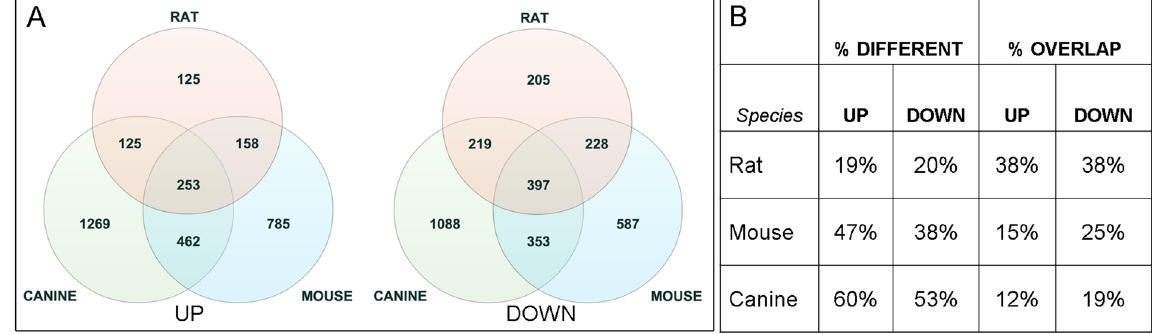
Figure 2. Rat, mouse, and canine glioma differentially expressed genes (DEG) Venn diagrams and data summary table. ( A ) Relative overlap of increased (UP) and decreased (DOWN) DEGs in rat, mouse, and canine PDGFRA-overexpressing glioma. ( B ) The unique and overlapping DEGs were compared by calculating the percentage of unique DEGs in the total DEG set for that species (% different) and the percentage of the common glioma DEGs represented within the total DEG set for that species (% overlap). The rat tumors had the lowest percentage of different DEGs and the greatest percent of common glioma genes represented within the total rat DEG set. The canine tumors showed the highest percent difference and the lowest percent overlap.